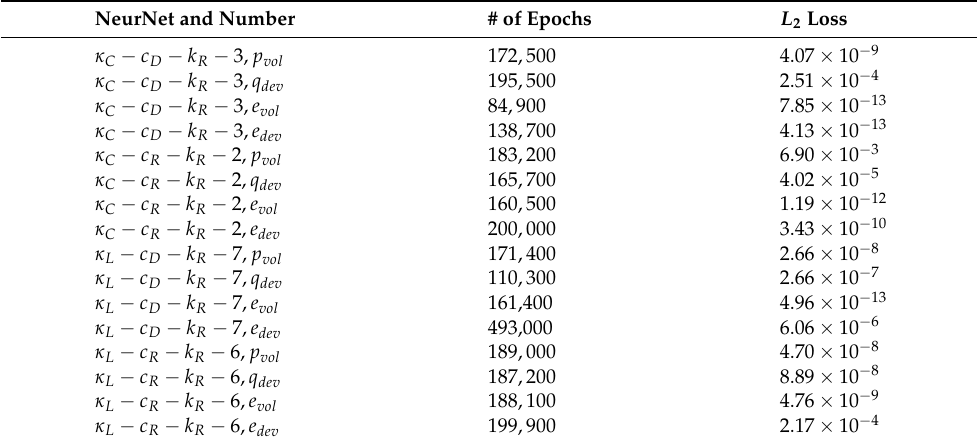
Table 4. Number of epochs for convergence and the corresponding L 2 loss for Neural Networks for Monte Carlo simulations of porous analyses with deterministic shape functions for the stochastic material variables ( κ considered linear over depth).